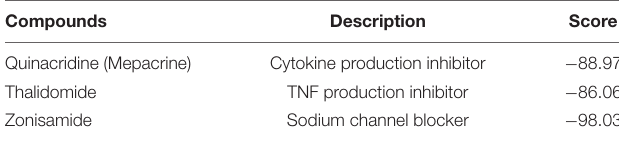
TABLE 4 | Potential drugs identified by CLUE and STITCH database for